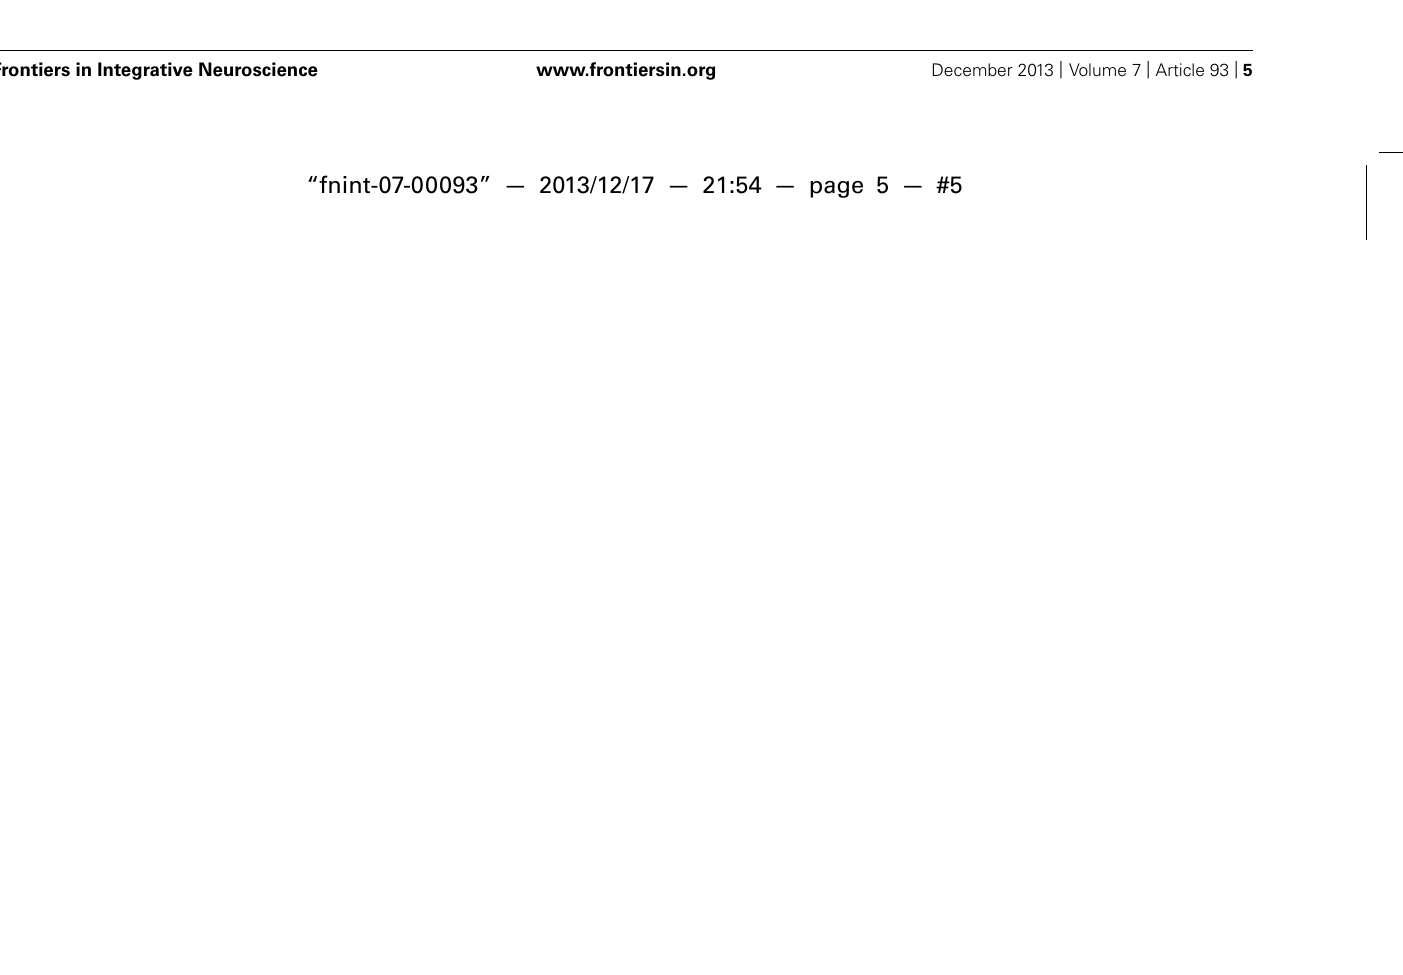
female and male LH rats, respectively. The arrowheads indicate the stimulus artifacts. The bottom panel shows peristimulus time histograms of the cells displayed in the top panel (100 consecutive sweeps). (B) Cumulative distribution plot of duration of inhibition from RMTg shows a reduced RMTg-evoked inhibition of VTA DA cells in female ( n = 15) and male ( n = 16) rats. (C) Summary graph histogram showing sex differences in averaged effect induced by RMTg stimulation on VTA DA cell activity. Data are expressed as mean ± SEM. * P <